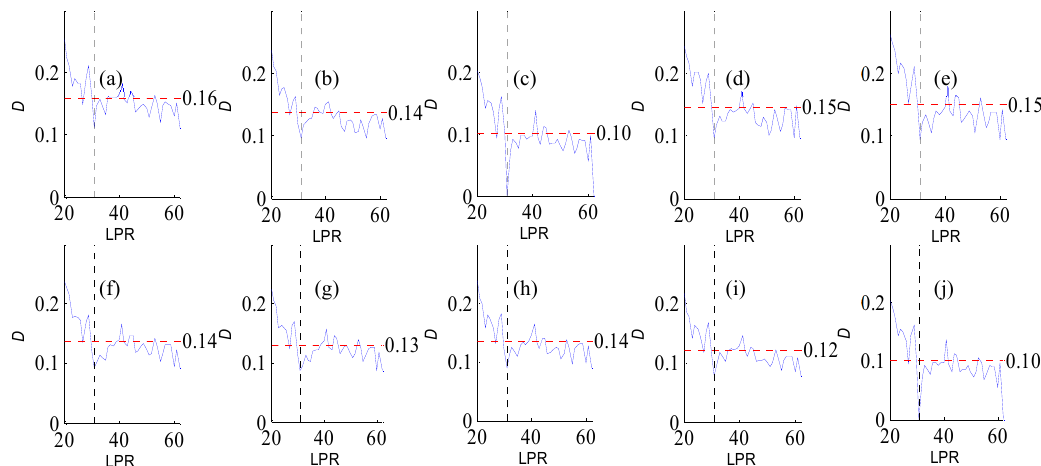
Figure A12. Variation of flow regime alteration degree (D) measured by the RVA with change in the length of post-impact flow time series (LPR) under a periodicity of 30 years. ( a ), ( b ), ( c ), ( d ), ( e ), ( f ), ( g ), ( h ), ( i ), and ( j ) correspond to pre-impact flow time series length = 21, 26, 30, 34, 39, 43, 47, 51, 56, and 60 years, respectively. The abscissa value for the vertical dotted line is 30. The ordinate value for the horizontal dotted line is the mean degree of flow regime alteration in each subfigure.